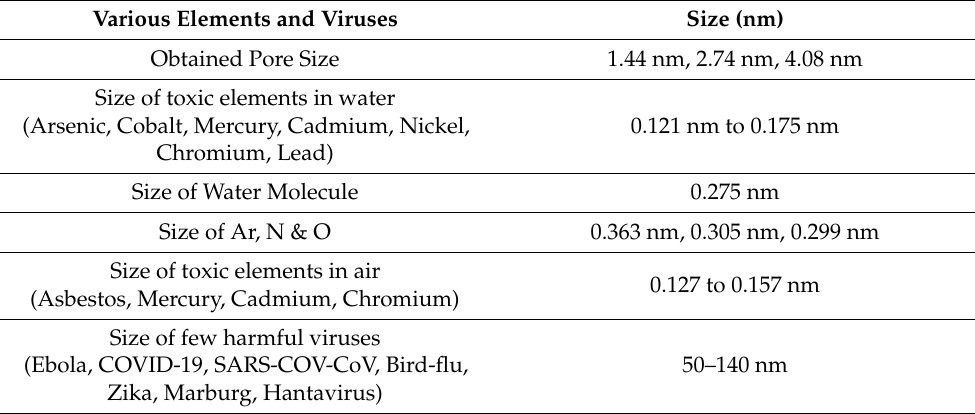
Table 5. Various potential applications where nanofibers can be